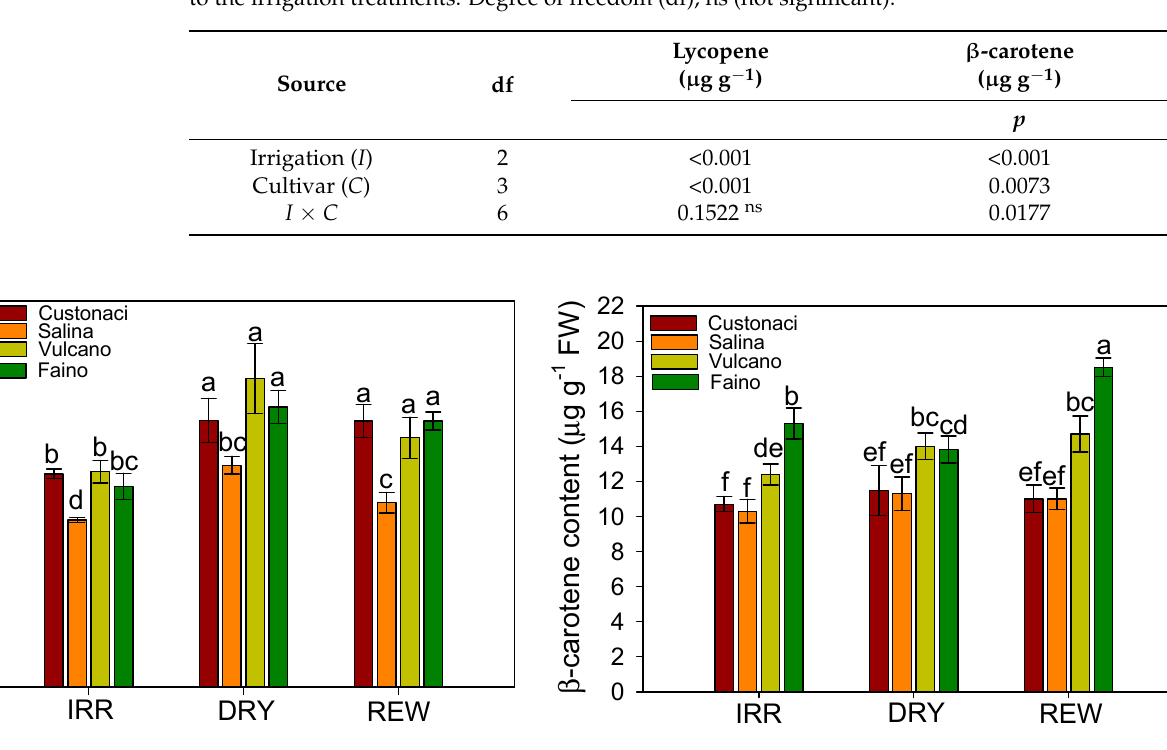
Figure 7. Relationships of fruit yield vs. polyphenols (total, flavonoids, HCQA, on the left ) and carotenoids (lycopene and β -carotene, on the right ) in tomato. Values of correlation coefficient ( r ) and significance (*, **, significant at p ≤ 0.05 and 0.01, respectively; ns, not significant) are reported.